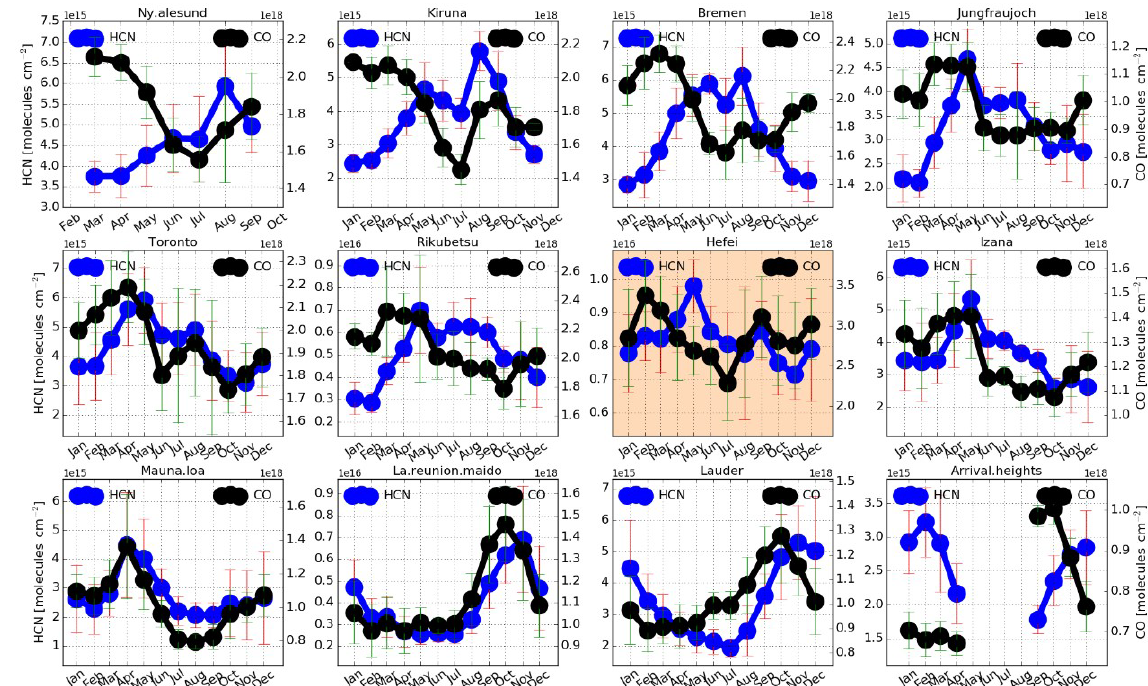
Figure 3. Monthly means of the tropospheric CO and HCN columns in Ny-Ålesund, Kiruna, Bremen, Jungfraujoch, Toronto, Rikubetsu, Hefei, Izana, Mauna Loa, La Reunion Maido, Lauder, and Arrival Heights from 2015 to 2018. Vertical error bars represent 1 σ within that month. All stations are organized as a function of decreasing